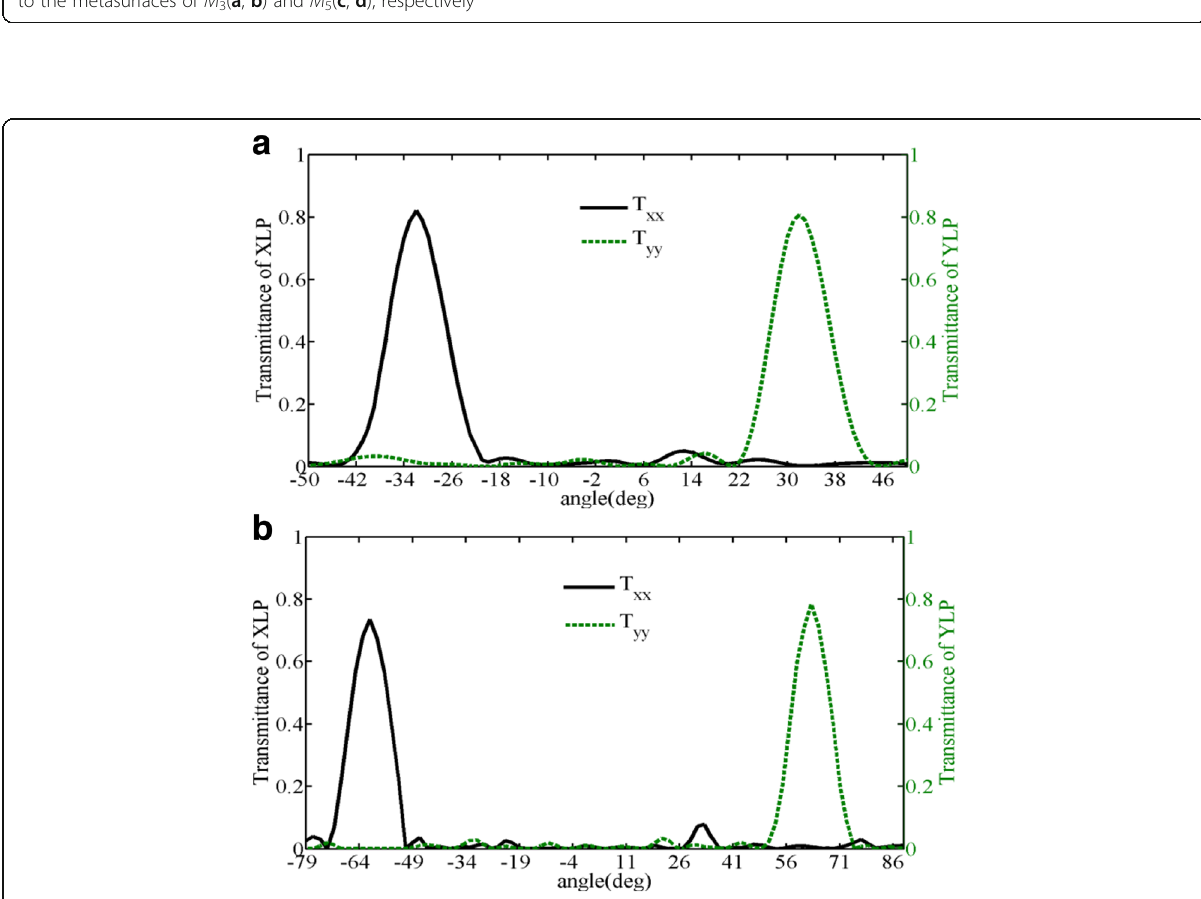
Fig. 5 The co-polarized transmitted efficiencies of the designed metasurfaces composed of rearranged supercell a M 3 and b M 5 as functions of the transmitted angle under the illumination of a X-polarized and Y-polarized light,